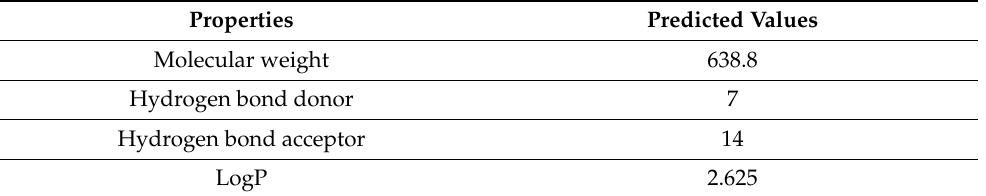
Table 2. Drug-likeness prediction results of ginsenoside rh1 based on Lipinski rule of 5.